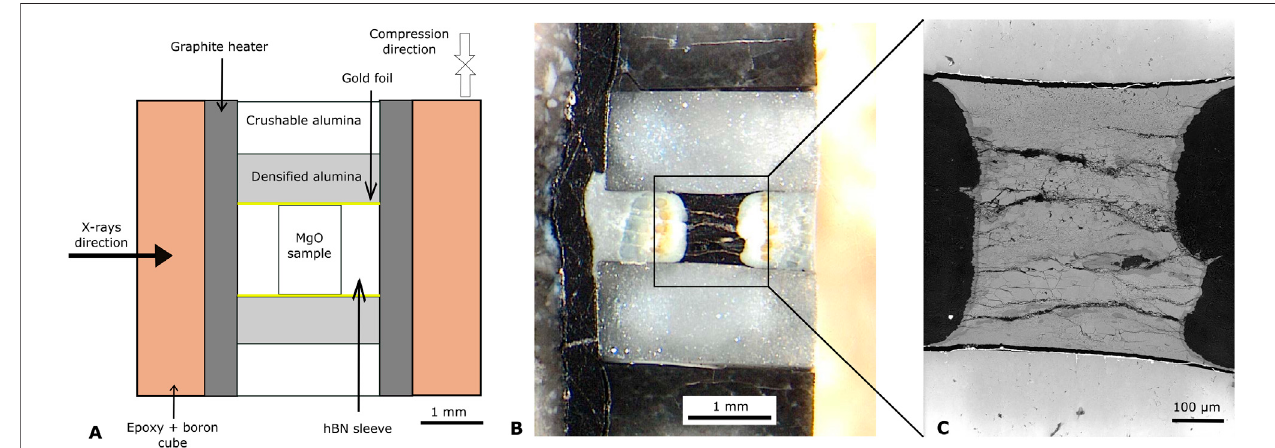
FIGURE 2 | Recovered samples. (A) Sketch of the D-DIA experimental assembly; (B) Optical image of sample D2032 after recovery and preparation for electron microscopy. The right part of the assembly was cut for sample preparation; (C) SEM image of the same